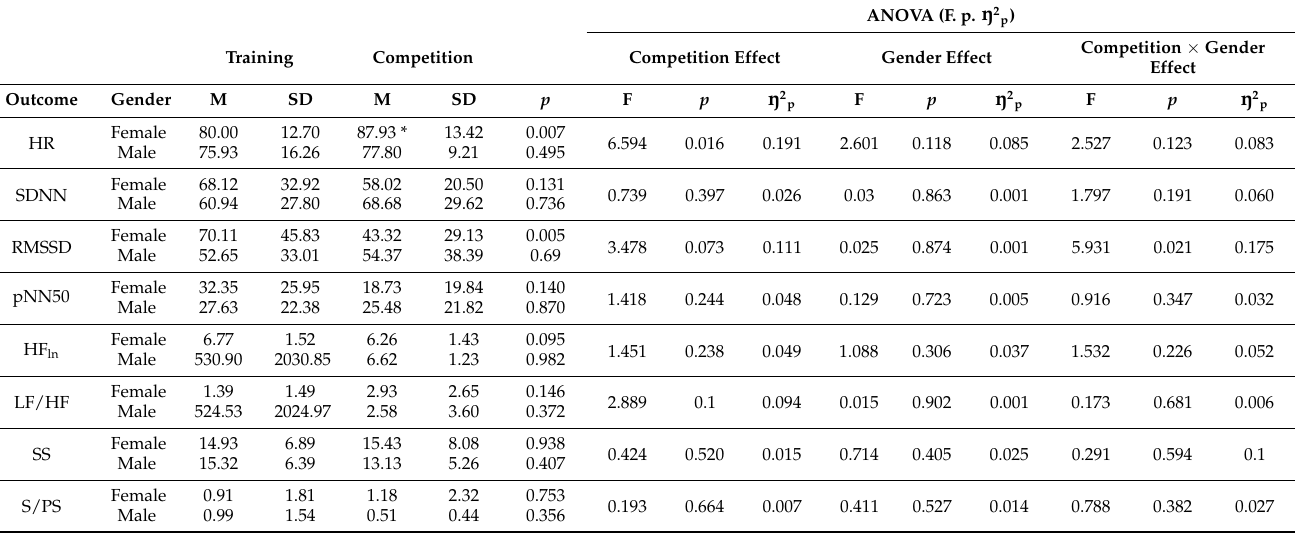
STA: State anxiety; COA: Cognitive anxiety; SOA: Somatic anxiety; SCONF: Self-confidence. * p < 0.05 compared to male.